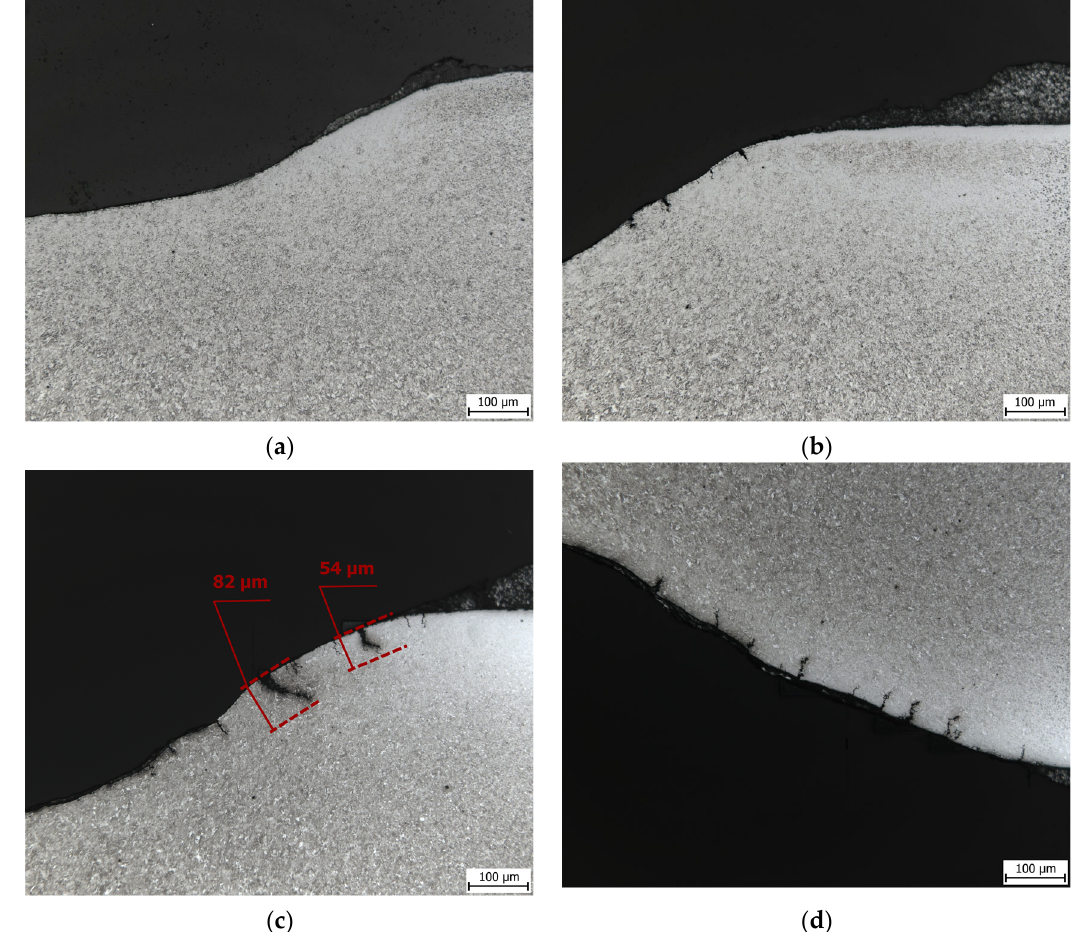
Figure 5. Detailed microstructure of critical areas with potential risk of LME occurrence: ( a ) 6 kA, ( b ) 6.5 kA, ( c ) 7 kA, ( d ) 7 kA.